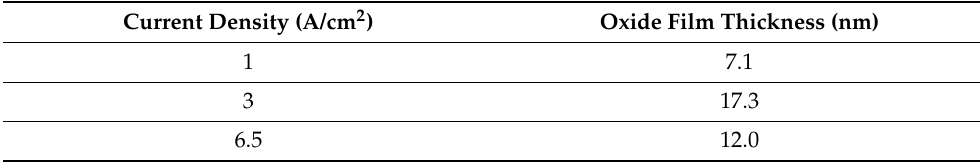
Table 2. The thickness of oxide film on the electrochemical polishing